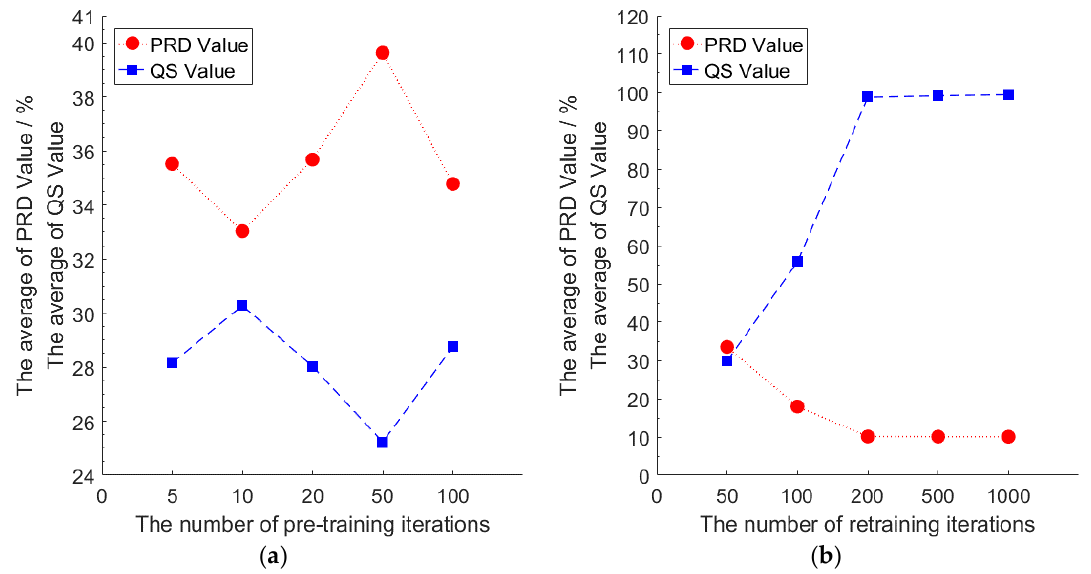
Figure 6. ( a ) Compression performance under different number of pre-training iterations without retraining; ( b ) compression performance under different retraining iterations with the number of pre-training iterations as 10.